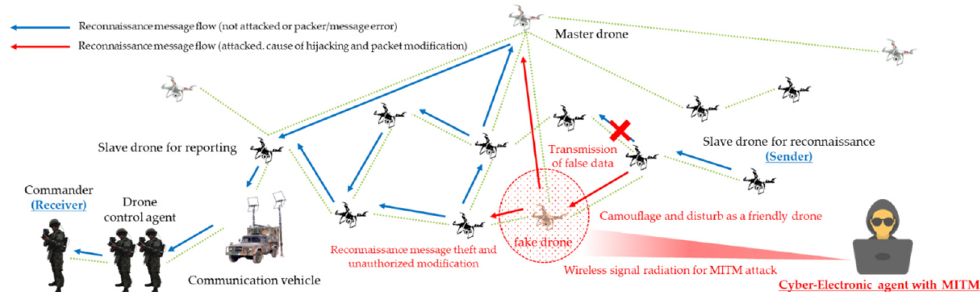
Figure 8. MITM (man-in-the-middle) attack scenario for reconnaissance report in a swarming communication drones maneuvering system.